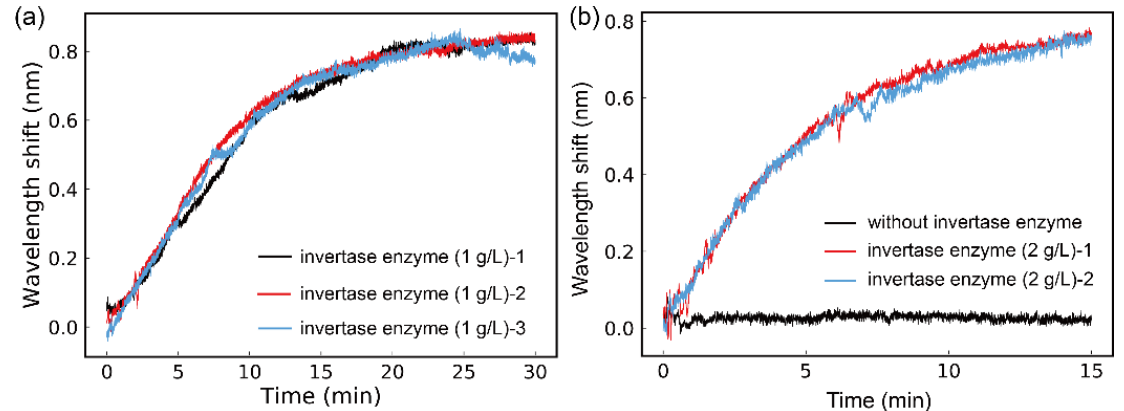
Figure 6. ( a ) The monitoring of the hydrolysis with 1 g/L of invertase enzyme. ( b ) Two hydrolysis measurements with 2 g/L of invertase enzyme and the measurement with not invertase enzyme.